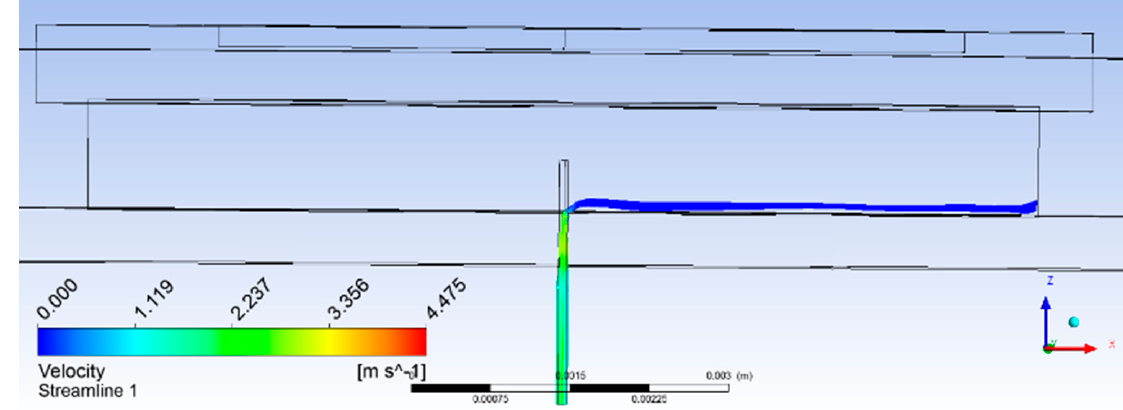
Figure 6. Streamlines plot with the 0.50-mm extended microneedle.